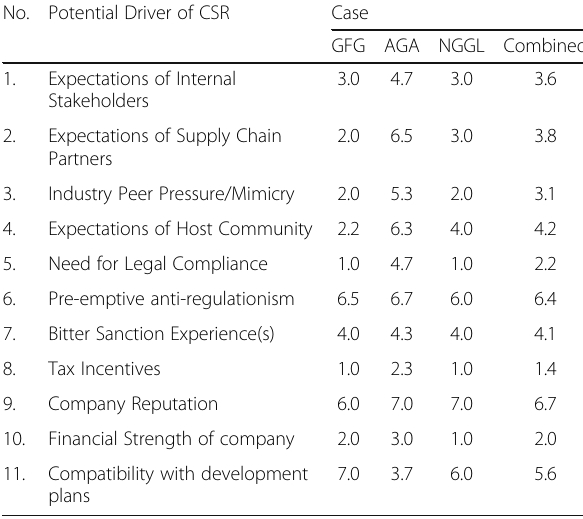
Table 2 Mean scores for drivers of CSR